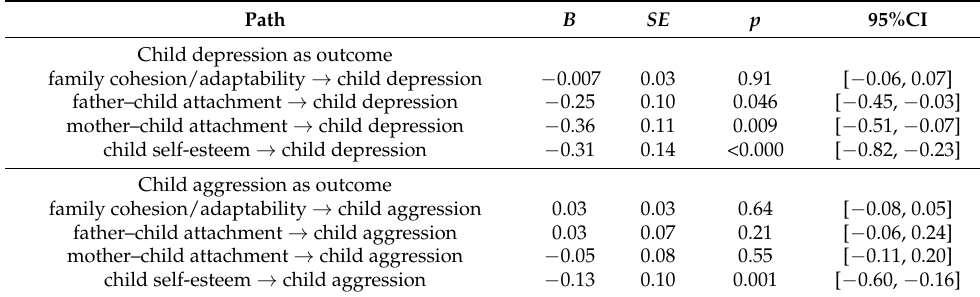
Figure 2. Results Model of Multilevel Family Factors and Emotional and Behavioral Problems of Children with ODD. Note: These are standardized model results and children’s gender and age, parents’ age and education, and family monthly income (not shown) were included as covariates in the model. * p < 0.05, ** p < 0.01, *** p < 0.001. Table 2. Direct Effects of Multilevel Family Factors on Child Outcomes.